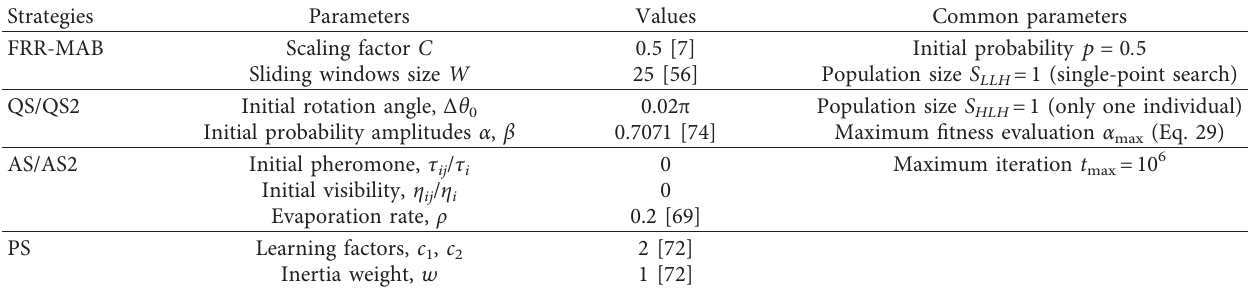
Figure 1: Framework of hyperheuristic approach. Table 2: Configuration for each selection